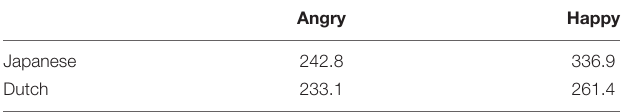
TABLE 1 | The average fundamental frequency (f0) of auditory stimuli (Hz). Angry